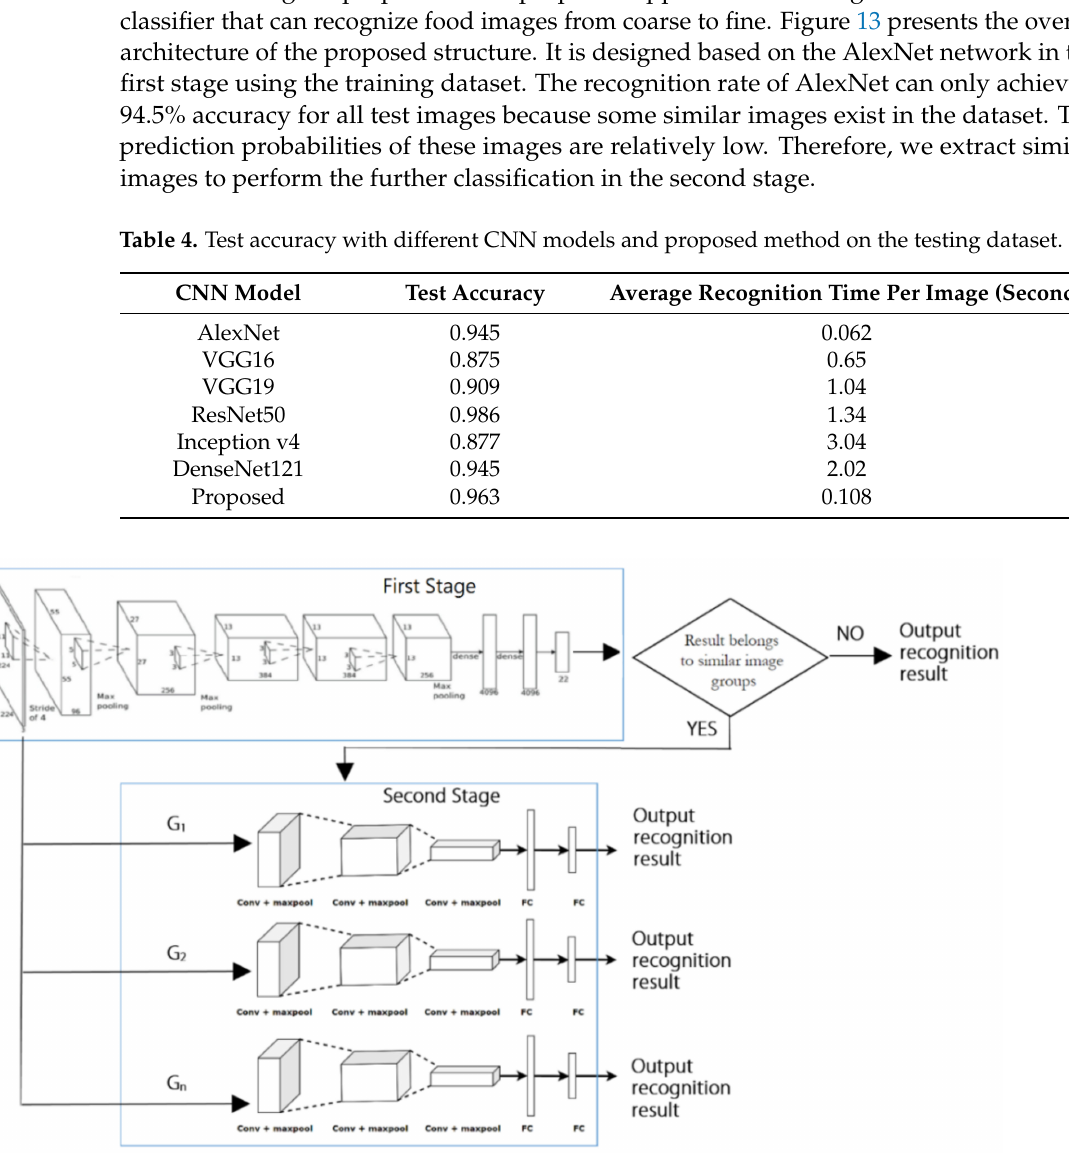
Figure 13. The overall architecture of the proposed two-stage hierarchical approach to enhance the recognition